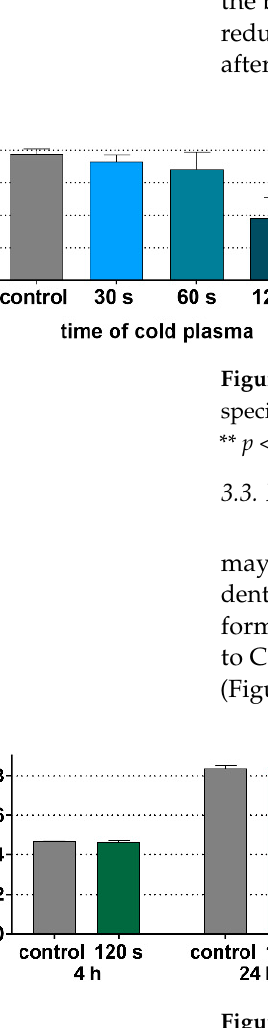
Figure 5. Colony forming units (CFU) counts ( A ) after 4 h and 24 h, mass ( B ), and metabolic activity ( C ) after 24 h of a multi-species biofilm formation on titanium specimens immediately after the ap- plication of 120 s of cold plasma . 3.4. Increased Adhesion of Gingival Fibroblasts to Titanium Surfaces after CAP Pretreatment Ideally, periodontal or peri-implantitis therapy should retard biofilm formation and enhance attachment of host cells, such as oral fibroblasts. The pretreatment of CAP for 120 s did not affect the adhesion of fibroblasts to the dentin surface (Figure 6A). On the tita- nium surface, the CAP treatment increased the adhesion of gingival fibroblasts to the ti- tanium surface by about 50% ( p < 0.001 vs. control; Figure 6B). Figure 6. Gingival fibroblast counts per mm 2 on dentin ( A ) and titanium ( B ) specimens after pre- treatment of 120 s of cold plasma. A B